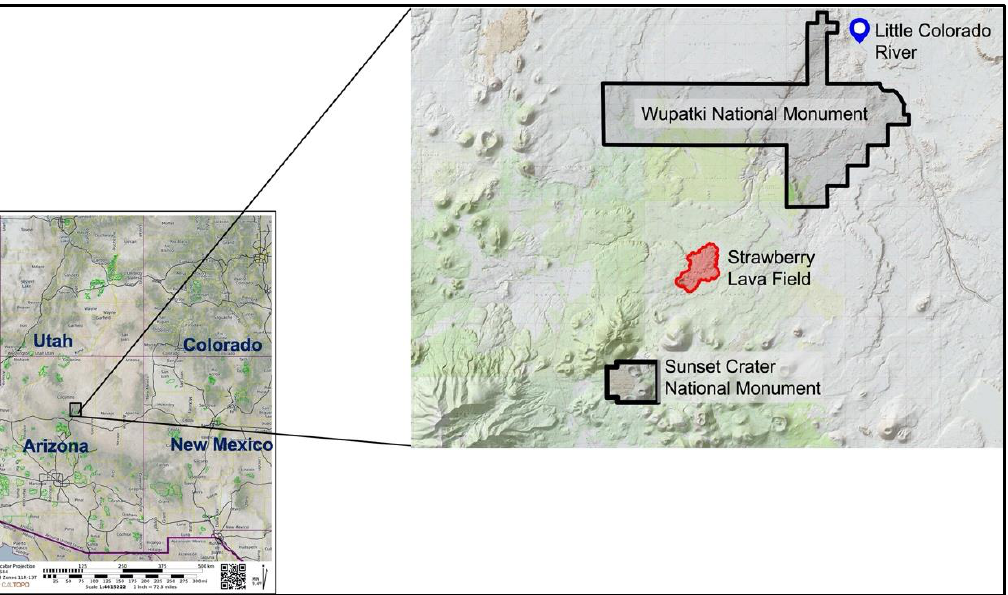
Figure 1. Wupatki and Sunset Crater Volcano National Monuments, north of Flagstaff, Arizona.